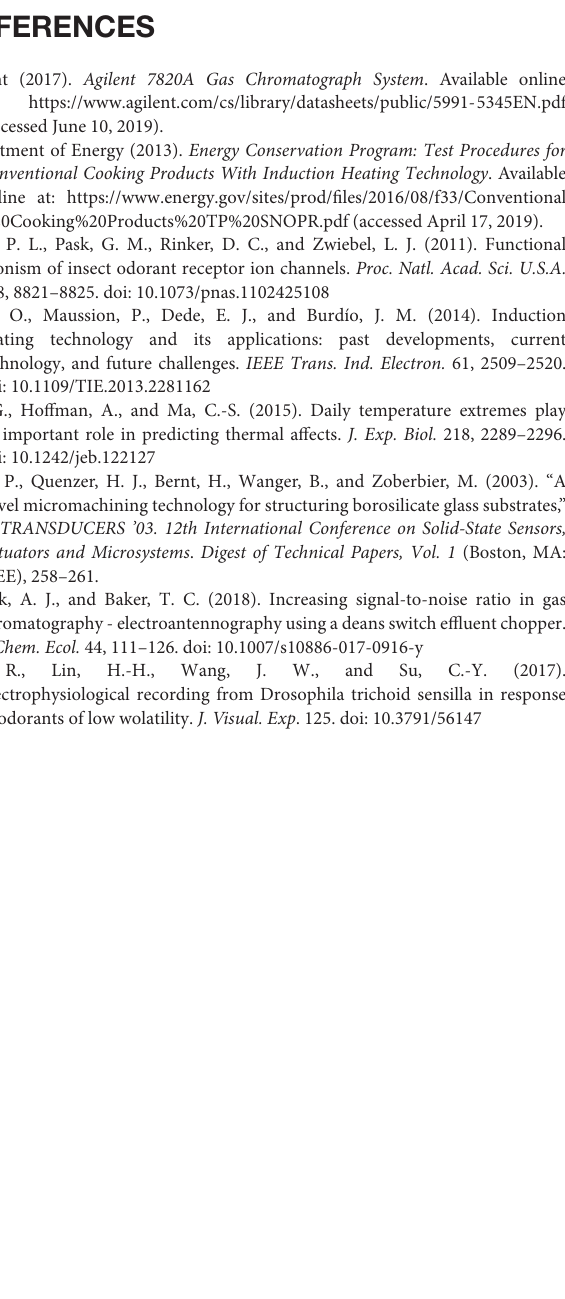
of the thermocouple alone black triangles in B , and of the thermocouple attached to the carbon steel wire (white circles in B ). Symbols are mean ± SEM; symbols apparently lacking error bars is because they are within the size of the